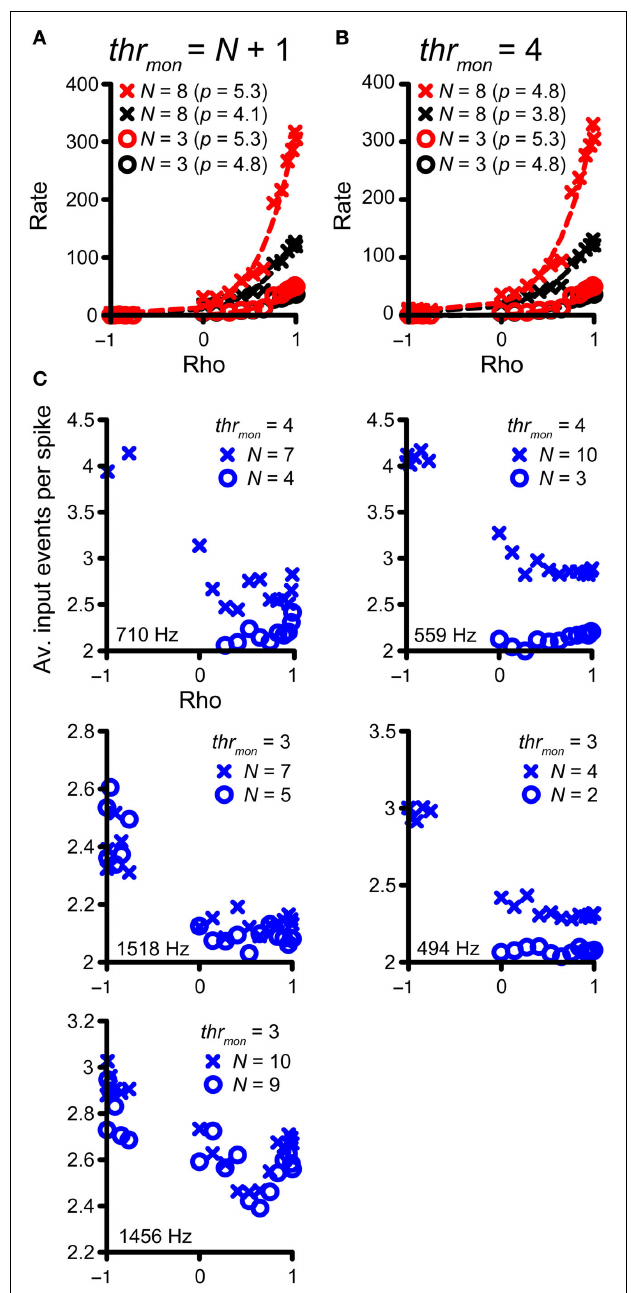
FIGURE 8 | Compression of rICF with convergence of inputs. (A,B) The same TB dataset as in Figure 4 is shown. In all cases, thr bin = 2 and cw = 50 µ s. rICFs are for simulations with N = 3 (circles) and N = 8 (crosses). (A) Simulations for output without monaural coincidences. thr mon is 4 and 9, respectively. The power p of the fit is stated in the caption. (B) rICFs with the same number of inputs as in (A) , but now the thr mon is fixed at 4. The ordinate in (B) is the same as in (A) . Dashed lines show the fits. (C) The average number of input events per successful output spike, as a function of ρ . Five TB datasets were selected that show the largest decrease in p with N , for thr mon = 3 or 4. Crosses correspond to the high N (lowest p ), circles correspond to the low N (highest p ). CF is indicated in each